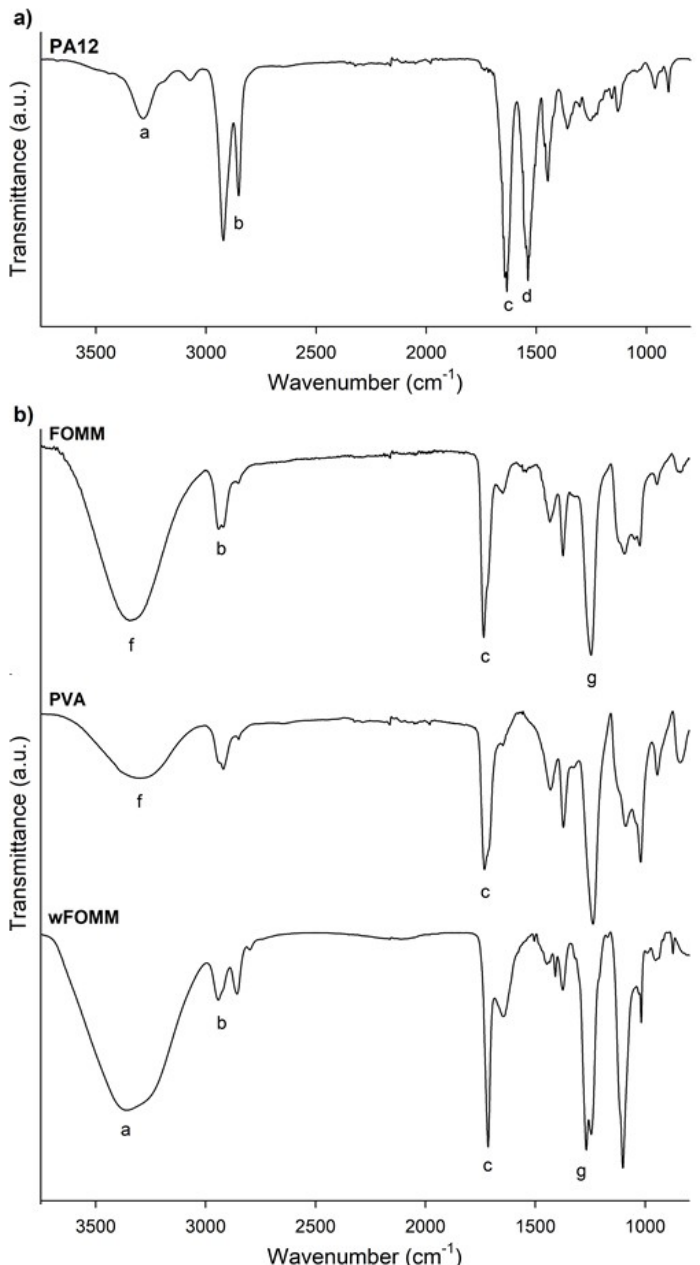
Figure 3. FTIR spectra of the polymeric filaments: ( a ) PA12, ( b ) FOMM, PVA and wFOMM. The letters (a–g) identify the characteristic bands discussed in the text.